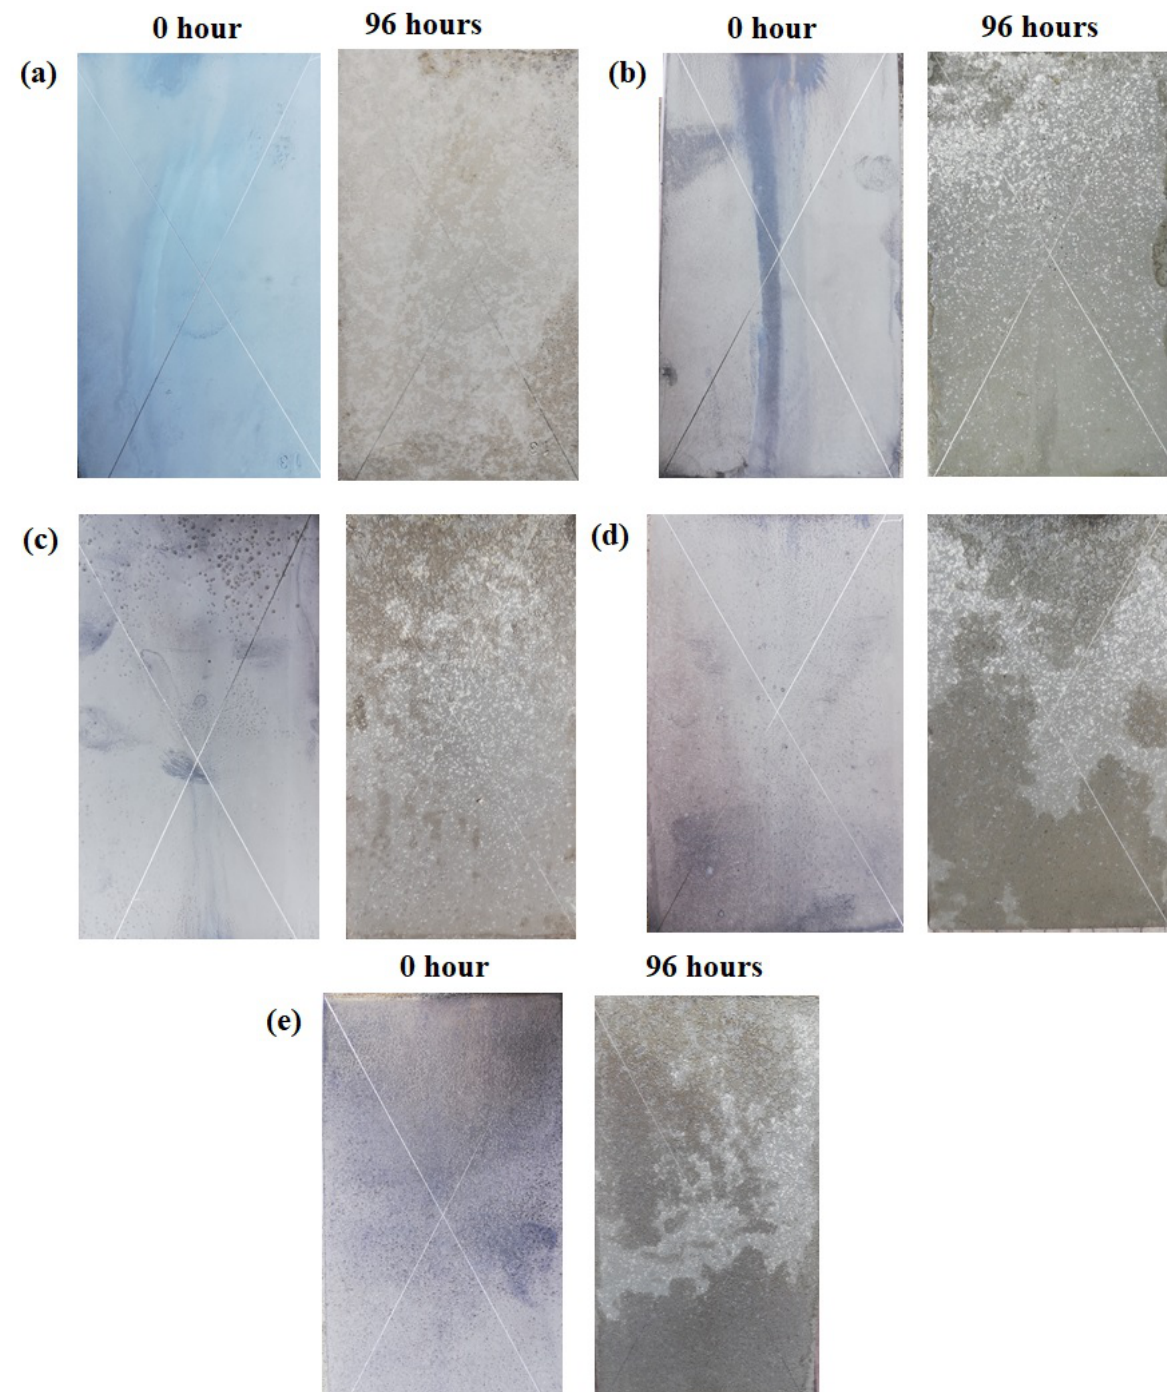
Figure 9. The surface appearance of coatings before and after salt spray tests: ( a ) Zn ( b ) Zn-Ni-10 ( c )